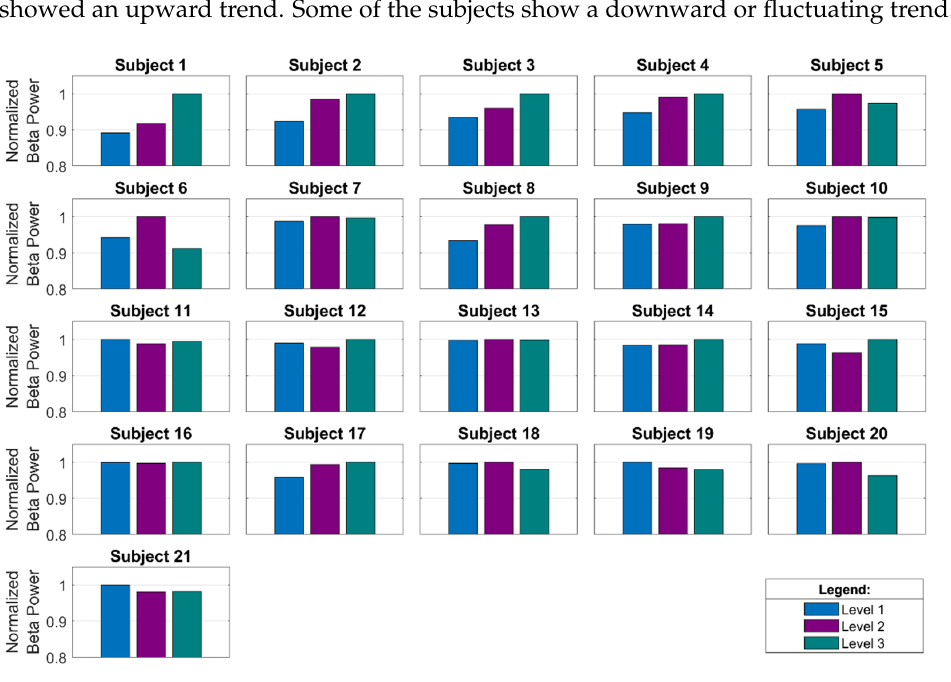
Figure 11. The beta/alpha ratio during the rest and gameplay.